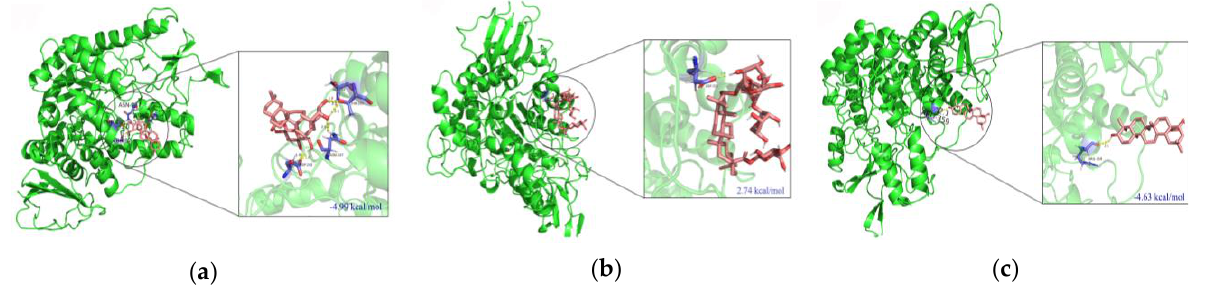
Figure 9. Molecular docking pictures of compounds 3 , 9 , and 13 on α -glucosidase of 3A4A. ( a ) 3D-structural model of α -glucosidase bound to compound 3 and the close-up view of the compound 3 molecule bound at the active site of α -glucosidase. ( b ) 3D-structural model of α -glucosidase bound to compound 9 and the close-up view of the compound 9 molecule bound at the active site of α -glucosidase. ( c ) 3D-structural model of α -glucosidase bound to compound 13 and the close-up view of the compound 13 molecule bound at the active site of α -glucosidase. The 3D-structural model of α -glucosidase is shown in green; residues that may be involved in the interactions of compound-binding are drawn with a stick model and shown in purple. The possible hydrogen-bond interactions are indicated with dashed lines (yellow).